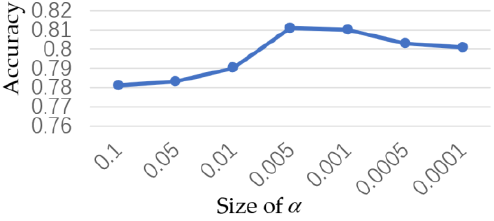
Figure 8. Adjustment of hyperparameter a .